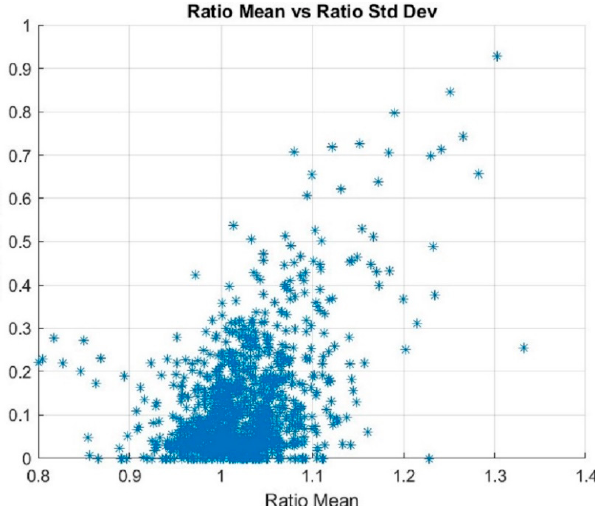
Figure 6. Ratio mean vs. ratio standard deviation. Note the discernable positive linear trend above a ratio standard deviation of 0.2 as the data drift to larger values. Since the ratio is derived by taking the reflectance of Landsat 8 to 9, this behavior could be a real and observable phenomenon. Image source: